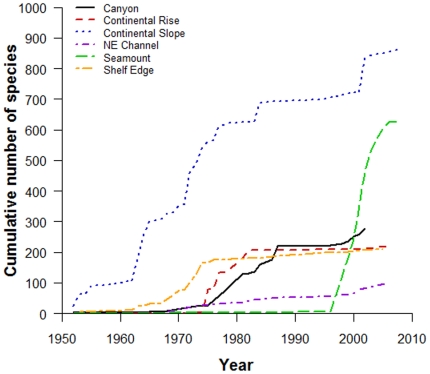
Cumulative number of known species in the deep-sea database within six sub-regions since 1950.